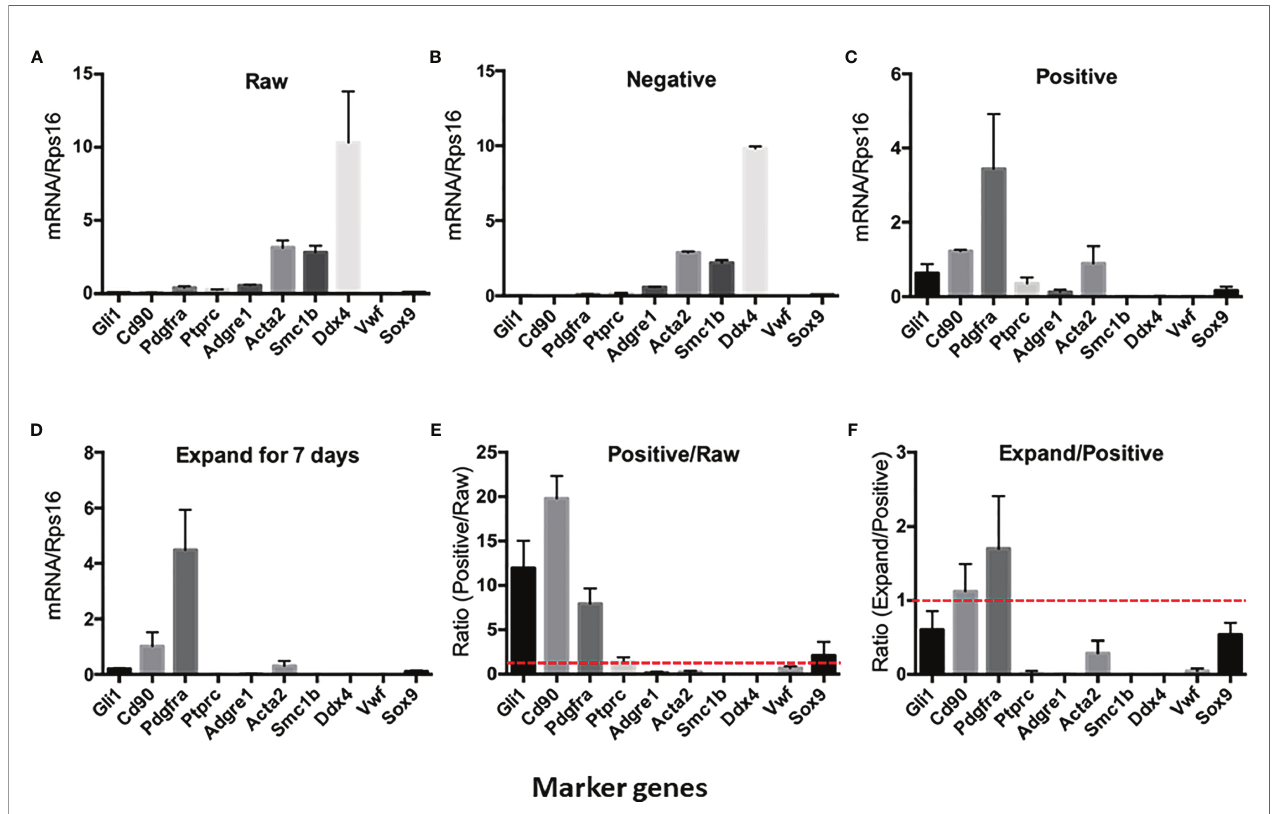
FIGURE 2 | Expression of testicular cell markers by cell suspensions at different enrichment steps: (A) Raw testicular cells before magnetic-activated cell sorting (MACS). (B) CD90 − cells after MACS. (C) CD90+ cells after MACS. (D) CD90+ cells cultured in expansion medium for 7 days. (E) Enrichment factors for each cell type by MACS procedure (ratios of CD90+ cells and raw cells). (F) Enrichment factors for each cell type by in vitro expansion (ratios of expanded cells and freshly sorted CD90+ cells). A ratio above onefold (broken red line) indicates positive enrichment. Data are expressed as mean ± SEM of four